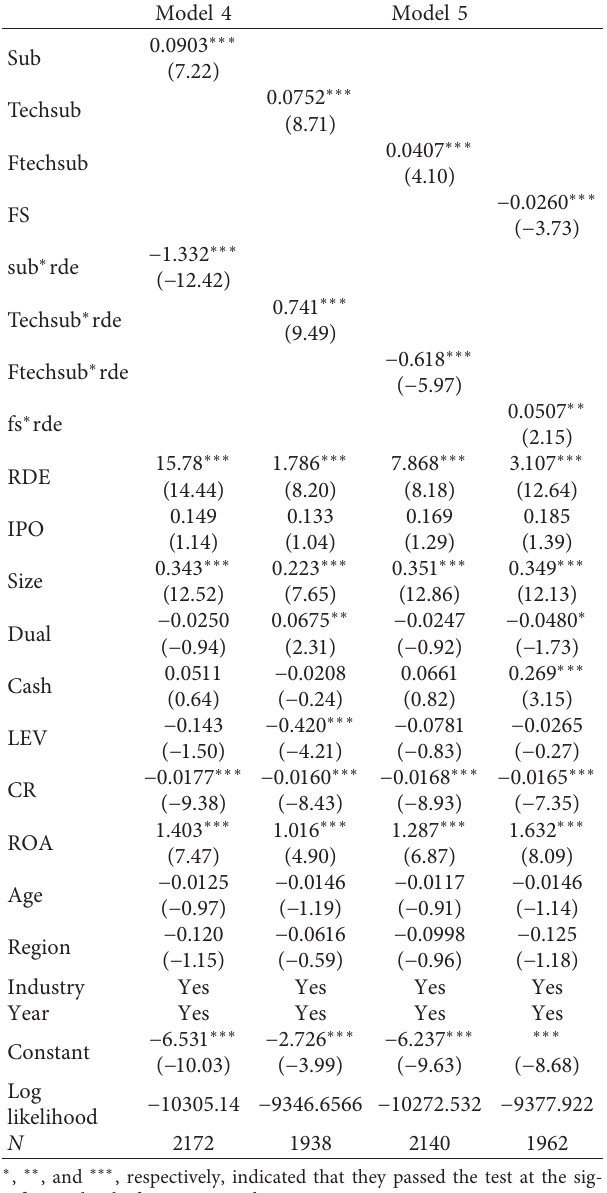
Table 5: Regulation of R&D